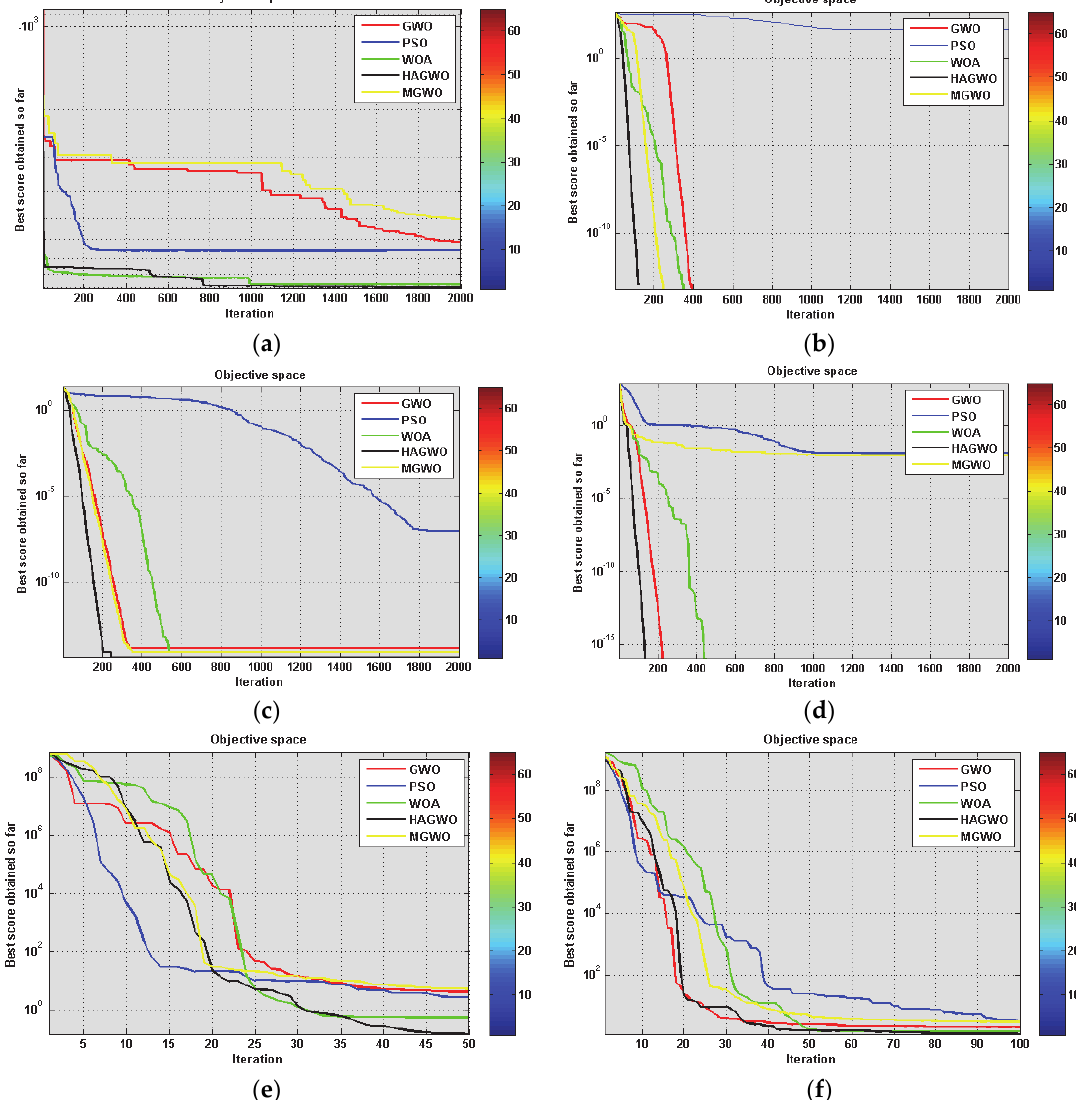
Figure 3. Convergence Curve of PSO, GWO, WOA, MGWO and HAGWO variants on Multimodal benchmark functions.